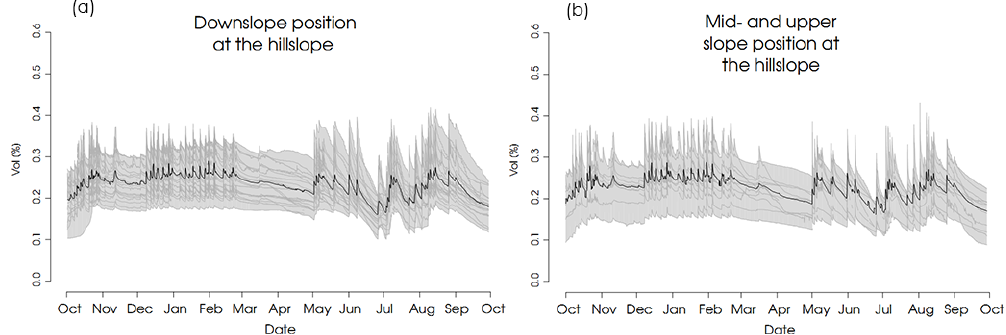
Figure D1. Soil moisture observations grouped by their landscape position. (a) Soil moisture observations at the hillslope foot and hence close to the river. (b) Soil moisture observations at the upper part of the